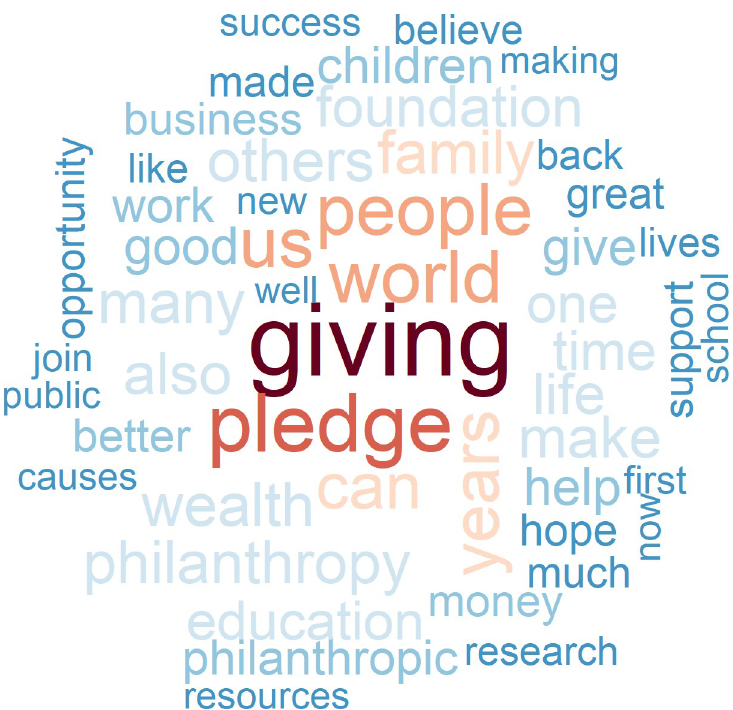
Fig 8. The 50 most frequently used words in the commitment letters submitted to the giving pledge by the tech elite versus no tech